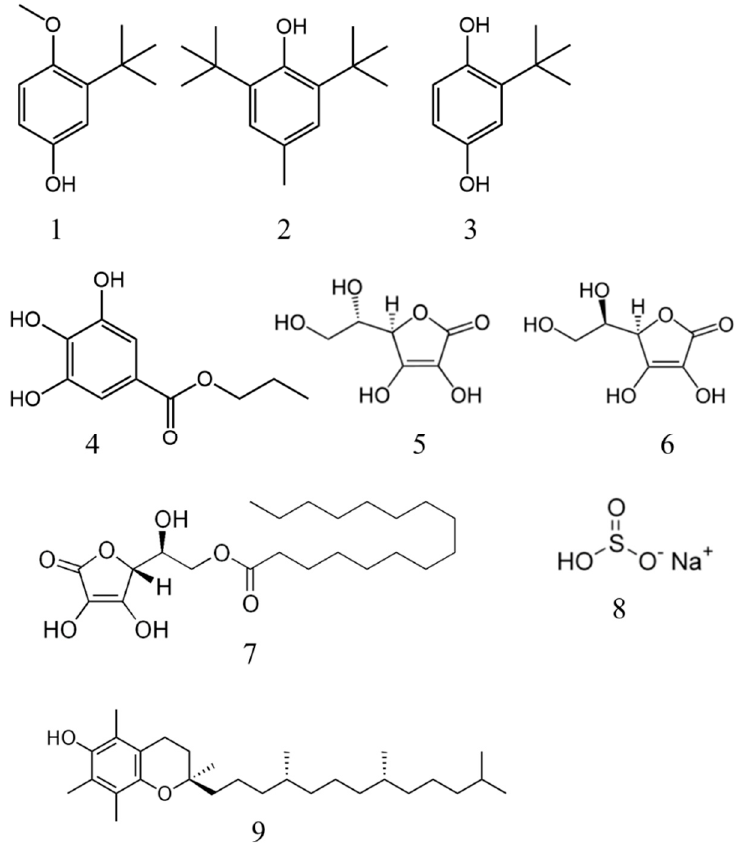
Figure 1. Chemical structures of food industry antioxidants. 1 : BHA, 2 : BHT, 3 : TBHQ, 4 : PG, 5 : ascorbic acid (vitamin C), 6 : erythorbic acid, 7 : ascorbyl palmitate, 8 : sodium bisulfite, 9 : vitamin E (alpha-tocopherol).